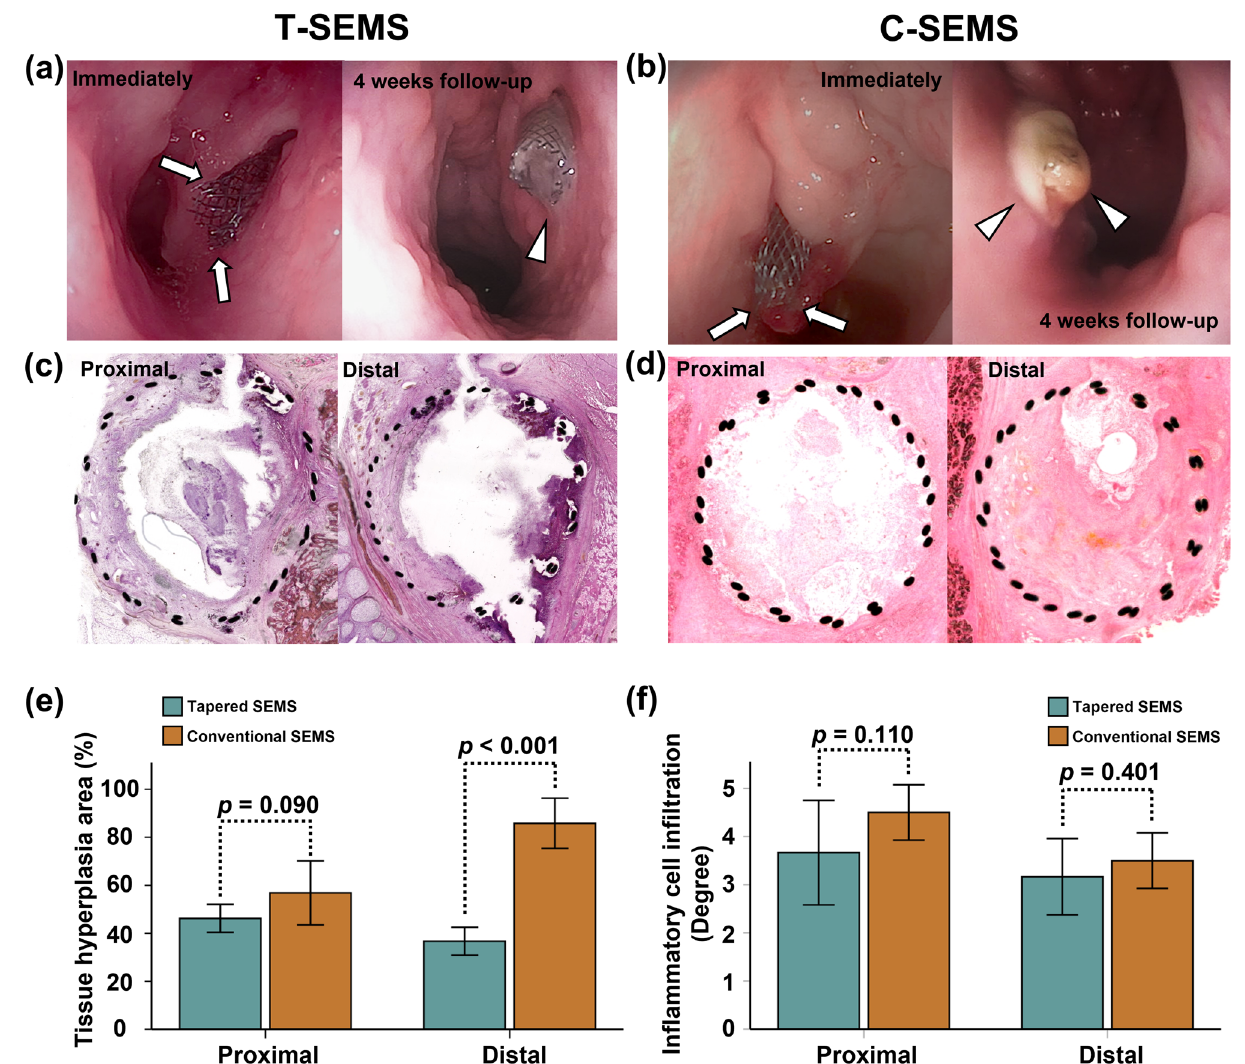
Figure 4. Representative endoscopic and histological images of the porcine ET. ( a ) Mild secretion ( arrow head ) around the T-SEMS ( arrows ) at 4 weeks. ( b ) Relatively severe secretion ( arrow heads ) was observed around the C-SEMS ( arrows ) at 4 weeks after the stent placement. ( c , d ) Histological images show significantly higher percentage of tissue hyperplasia in the distal portion of the C-SEMS group than that of the T-SEMS group. Histological results of the ( e ) percentage of tissue hyperplasia and ( f ) degree of inflammatory cell infiltration at 4 weeks after the stent placement in the T-SEMS and C-SEMS groups. T-SEMS tapered self-expandable metallic stent, C-SEMS conventional self-expandable metallic